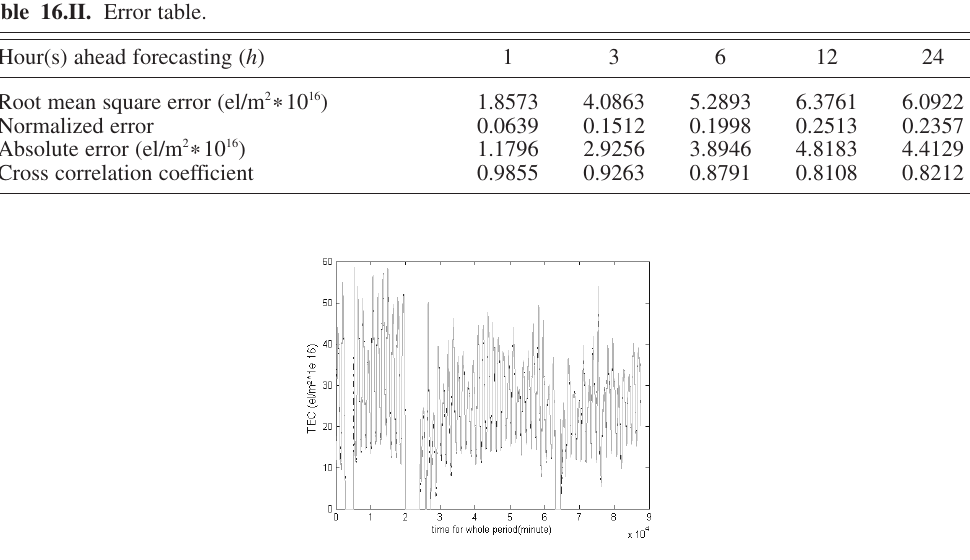
Fig. 16.2. Observed GPS-TEC results (dotted), 1 h ahead Forecast (solid) TEC values for the whole time of validation period: April-May 2002 for Halisham.